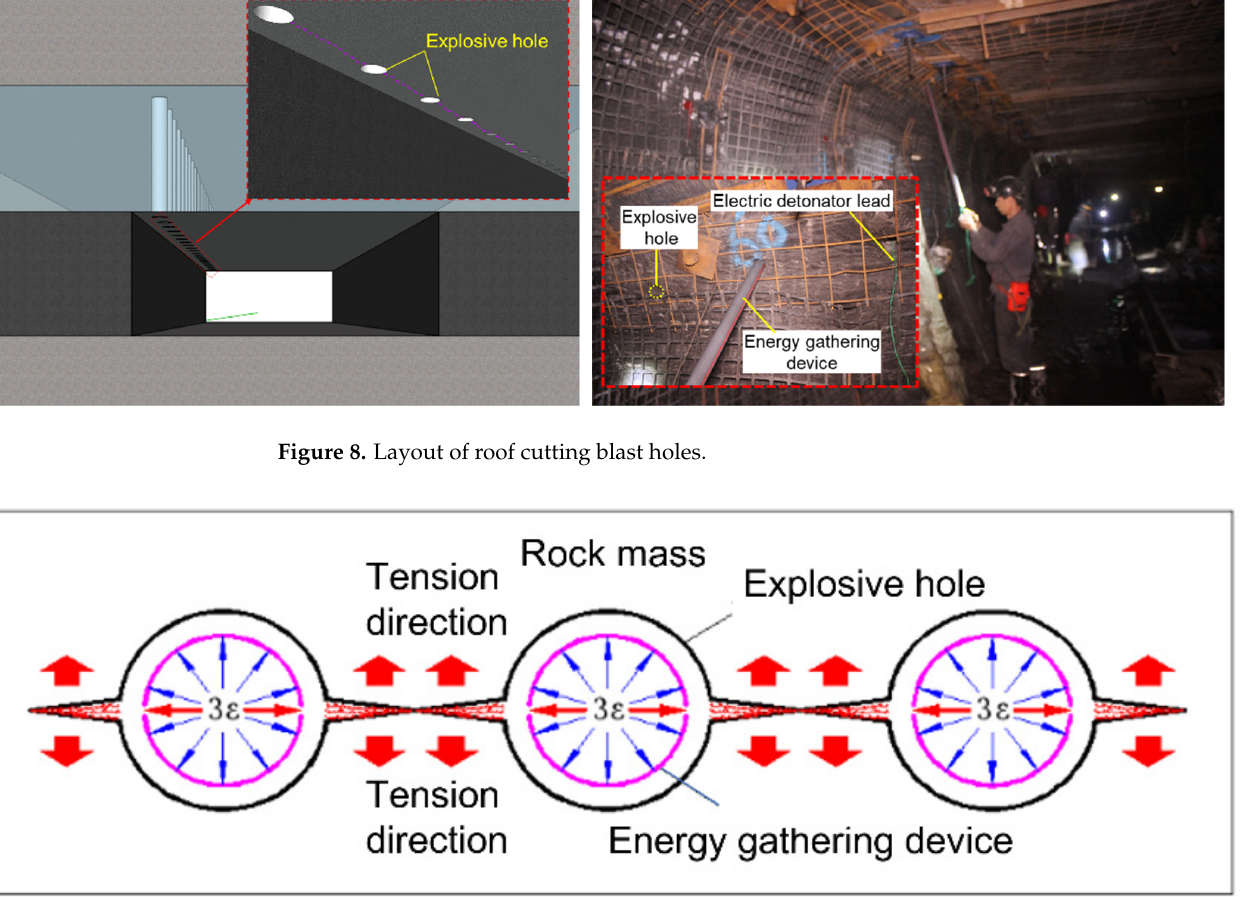
Figure 9. Principle of concentrated energy blasting technology.